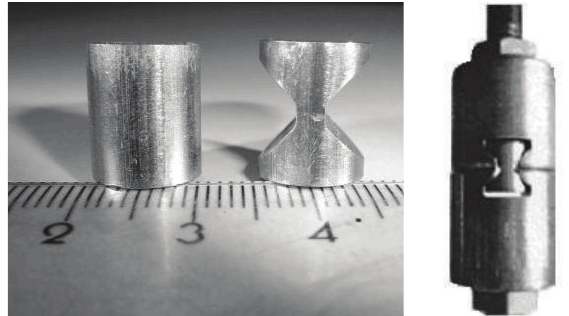
Figure 3: The shape of samples and equipment to the “button cell